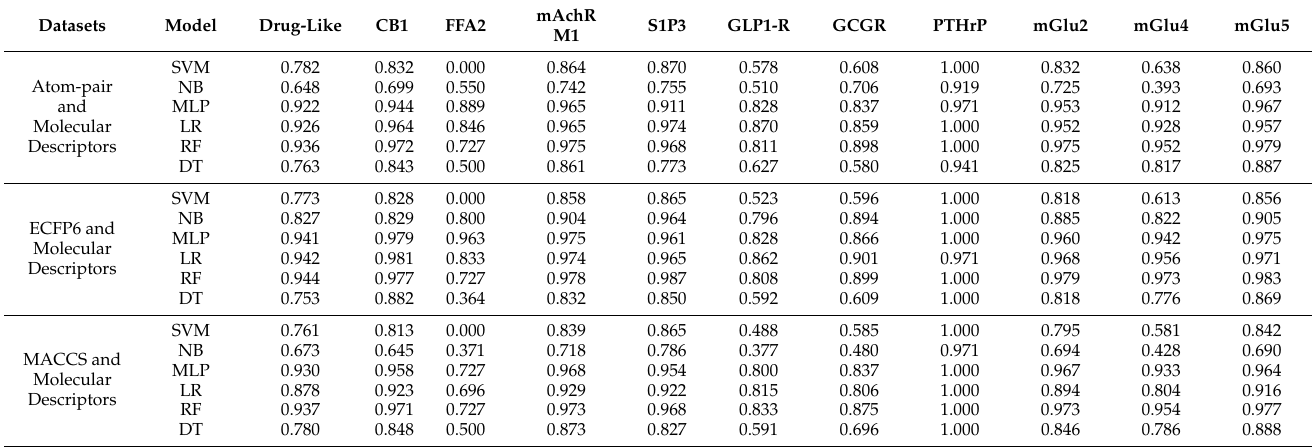
Table 7. The f 1 -score of the Test Set on Each Dataset with Two Feature Types on Each GPCR Class.